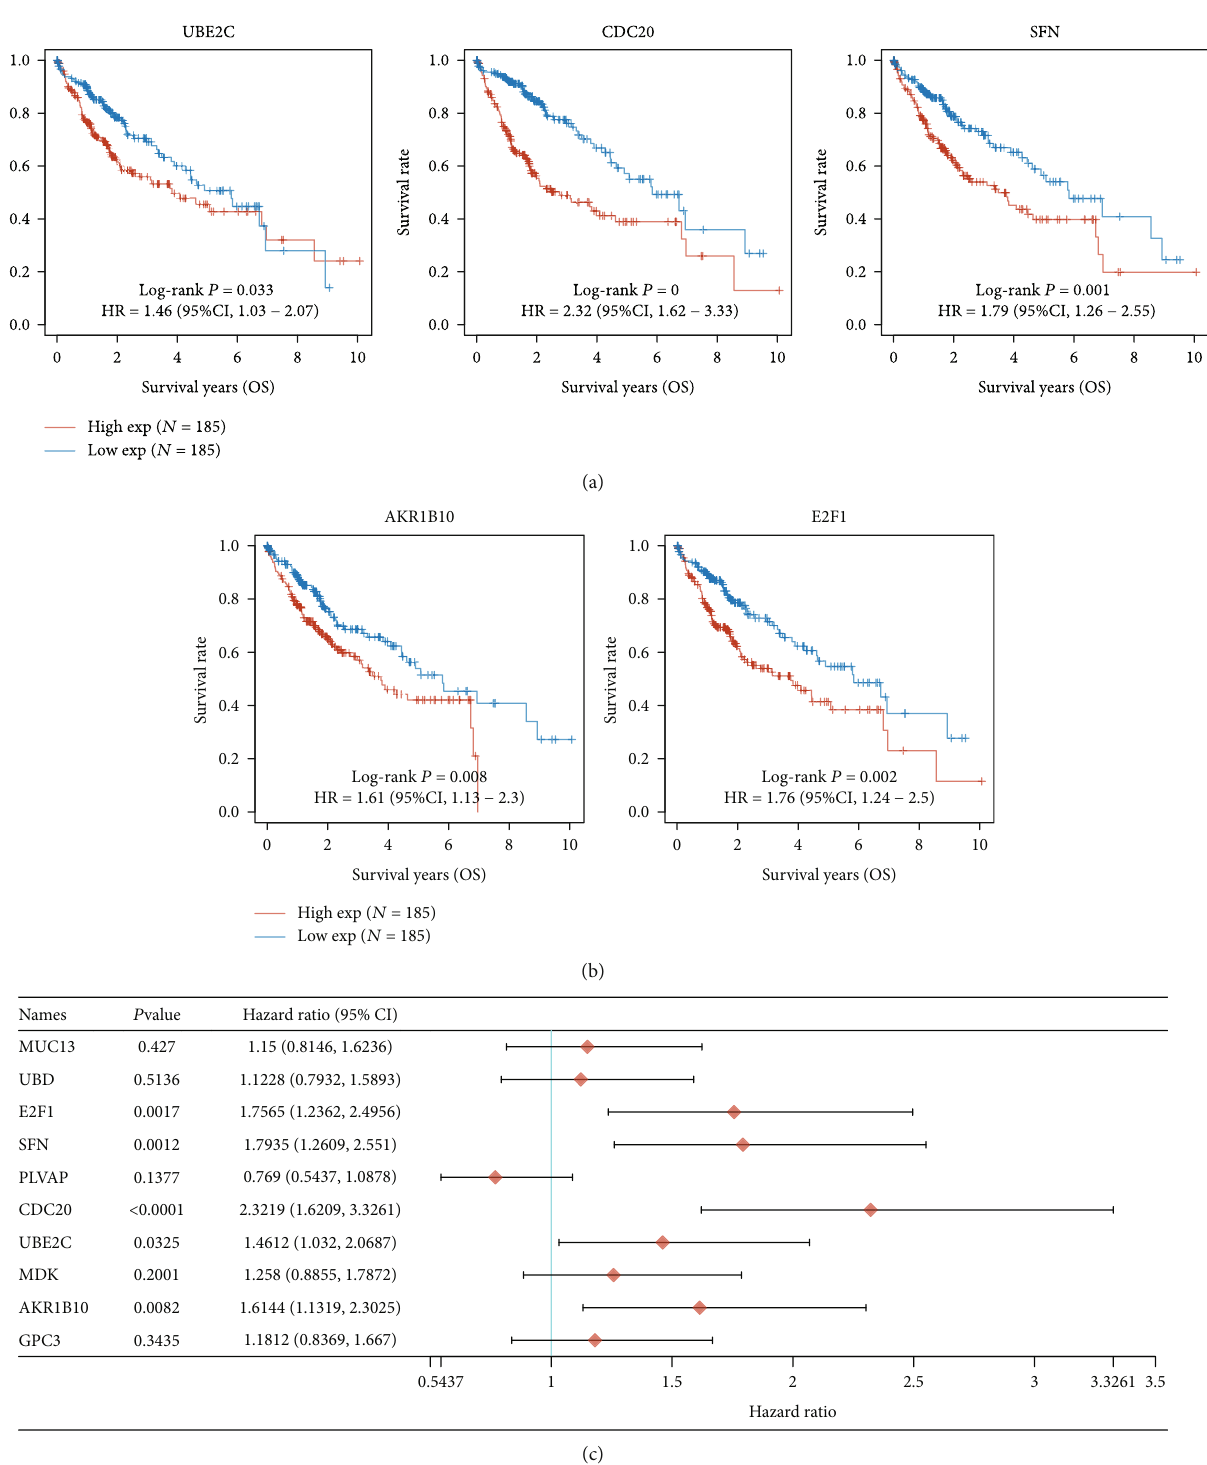
Figure 3: Identi fi cation of total genes having a correlation with survival in HCC using the top 10 overexpressed genes. (a, b) UBE2C, CDC20, SFN, AKR1B10, and E2F1 were identi fi ed to be high risk factors via Kaplan-Meier tests. (c) Univariate Cox regression